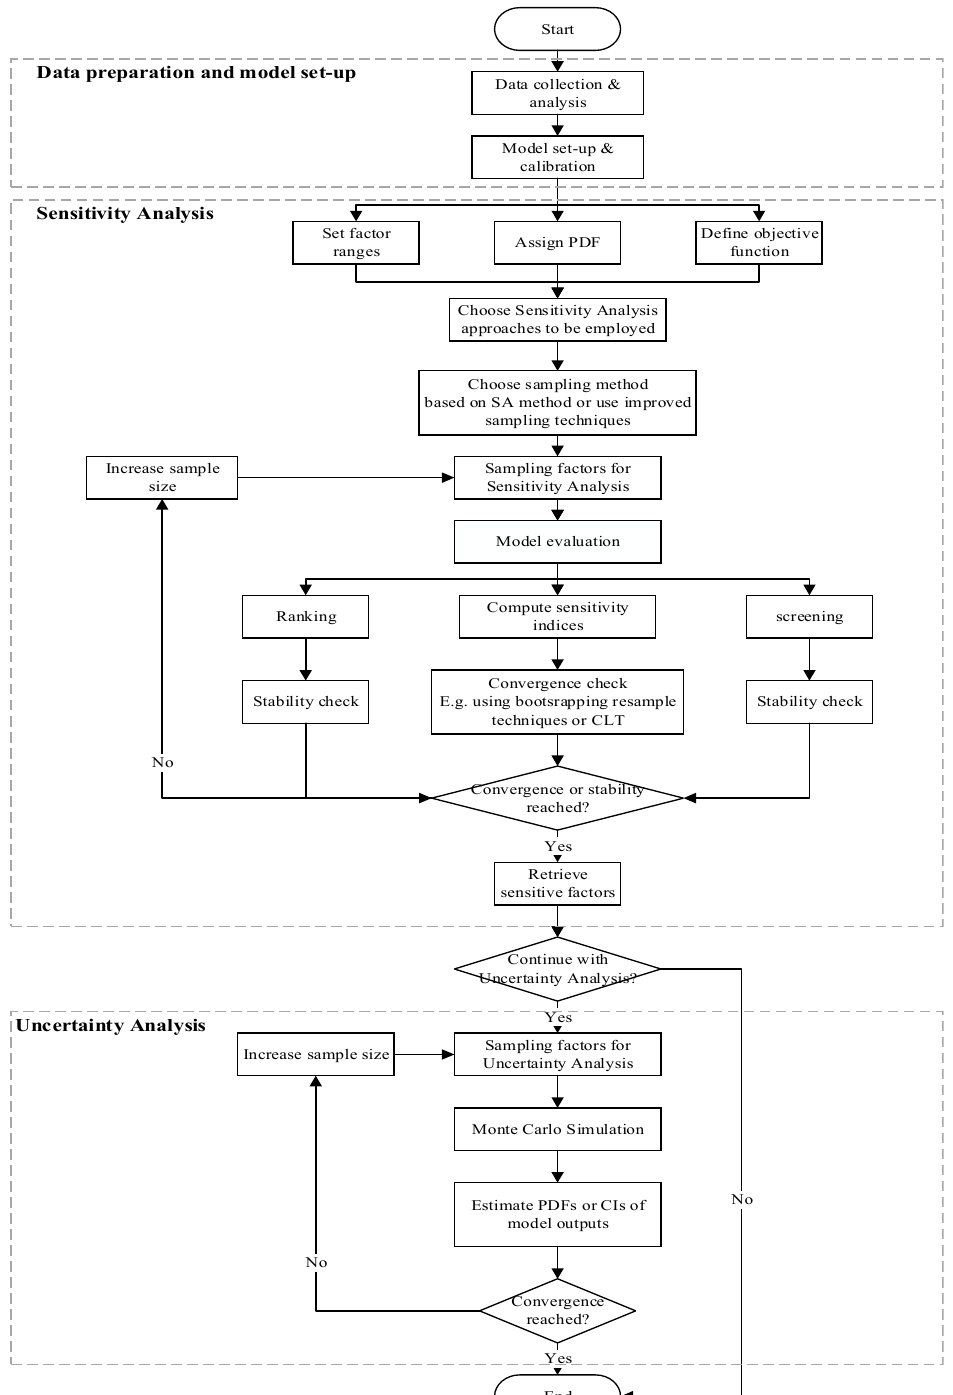
Figure 13. Framework for Sensitivity Analysis and Uncertainty Analysis of hydrological